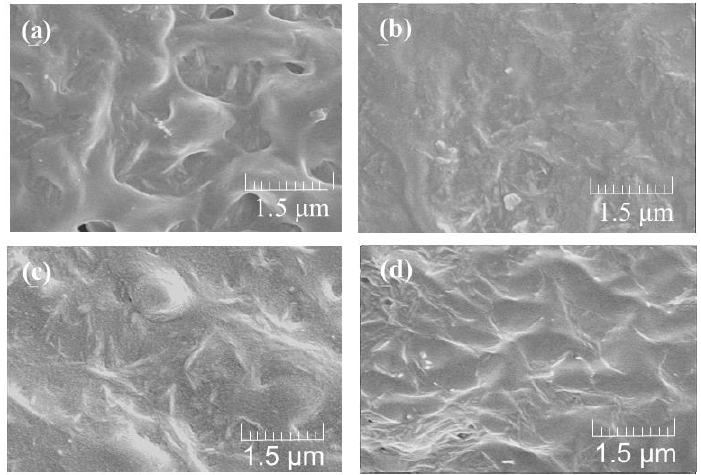
Figure 4. SEM images of self-assembled CNF-NR composite sheets ( a – d ;CNF:NR (weight ratio) = 0.01, 0.02, 0.1, 0.2:1, respectively.